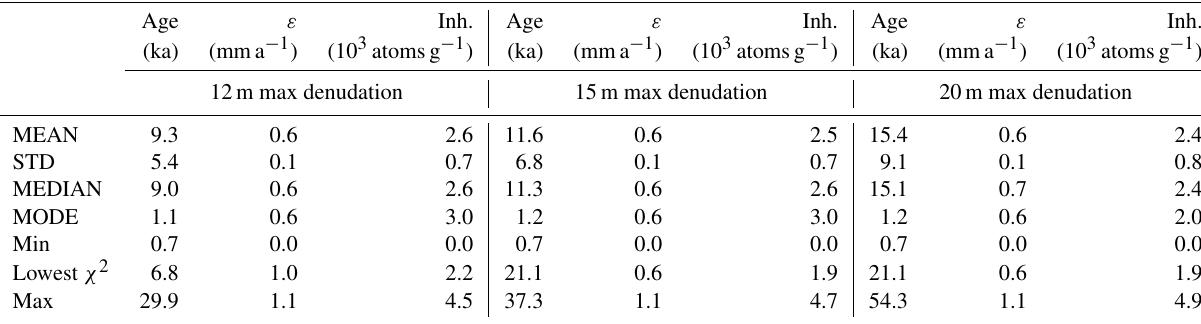
Table A3. Result statistics for Monte Carlo (MC) depth profile modeling of profile EW-01. Age ε